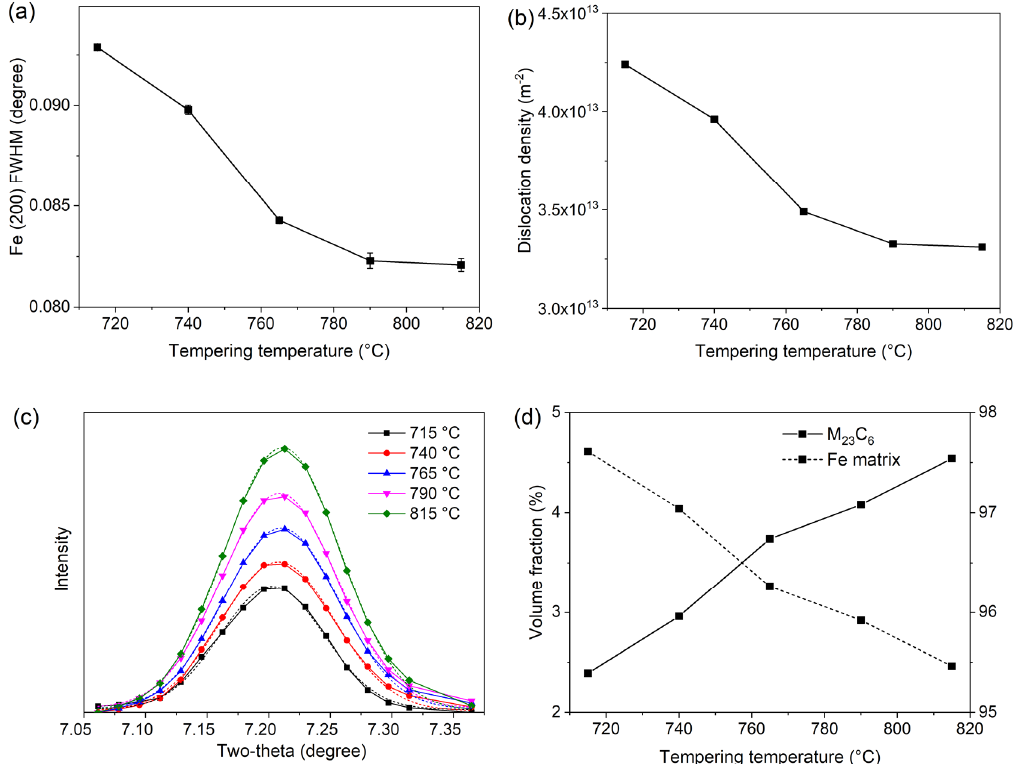
Figure 4. ( a ) Fitted full wave at half maximum (FWHM) of the Fe (200) peak, ( b ) calculated dislocation density in the Fe matrix, ( c ) the peak intensity of the M 23 C 6 (420) plane, and ( d ) volume fractions of the Fe matrix and M 23 C 6 phase estimated by integrated intensities of diffraction peaks in the T92 steel tempered at different temperatures characterized by SR-XRD.